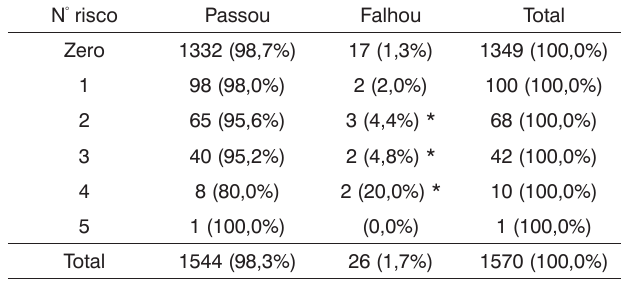
Tabela 2. Resultado da TAN, segundo número de indicadores de risco para a deficiência auditiva.